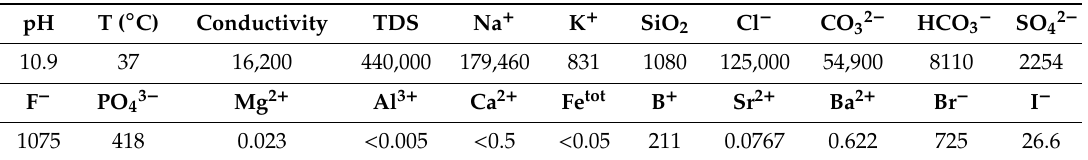
Table 1. Chemical analysis of the Lake Magadi water used for mineral garden and vesicle synthesis. Elemental concentrations are in ppm, conductivity in mS /